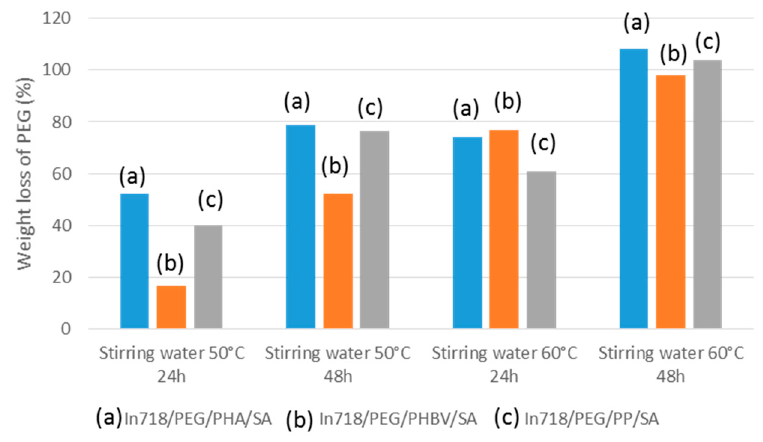
Figure 5. Weight loss of PEG for the different feedstocks after debinding in stirring water at 50 °C and 60 °C during 24 h and 48 h.